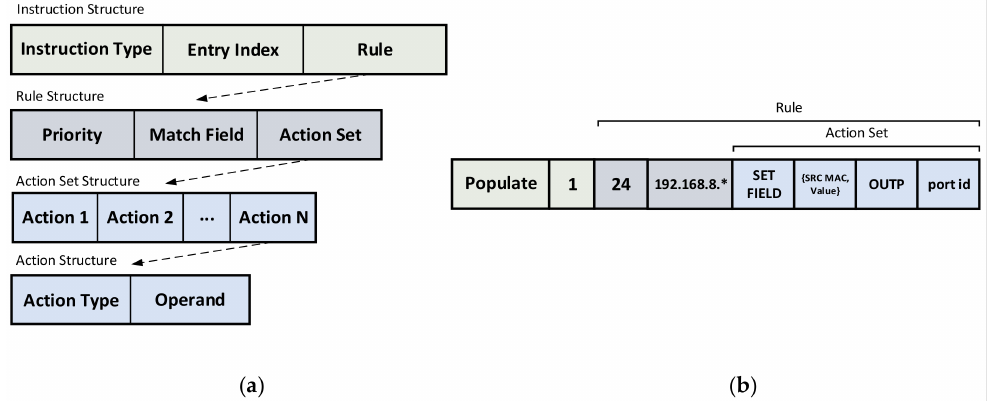
Figure 14. The structure of instruction. ( a ) Detailed structural composition of the instruction; ( b ) an example of the